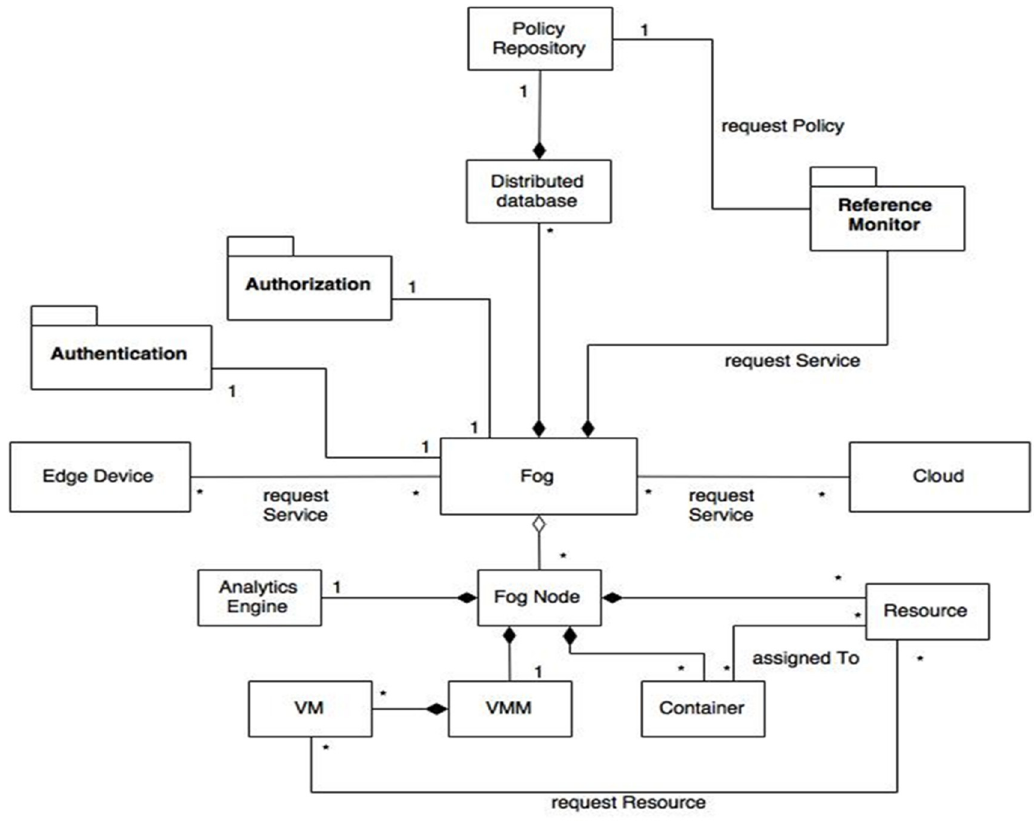
Figure 7. Class diagram of the Fog Computing pattern.